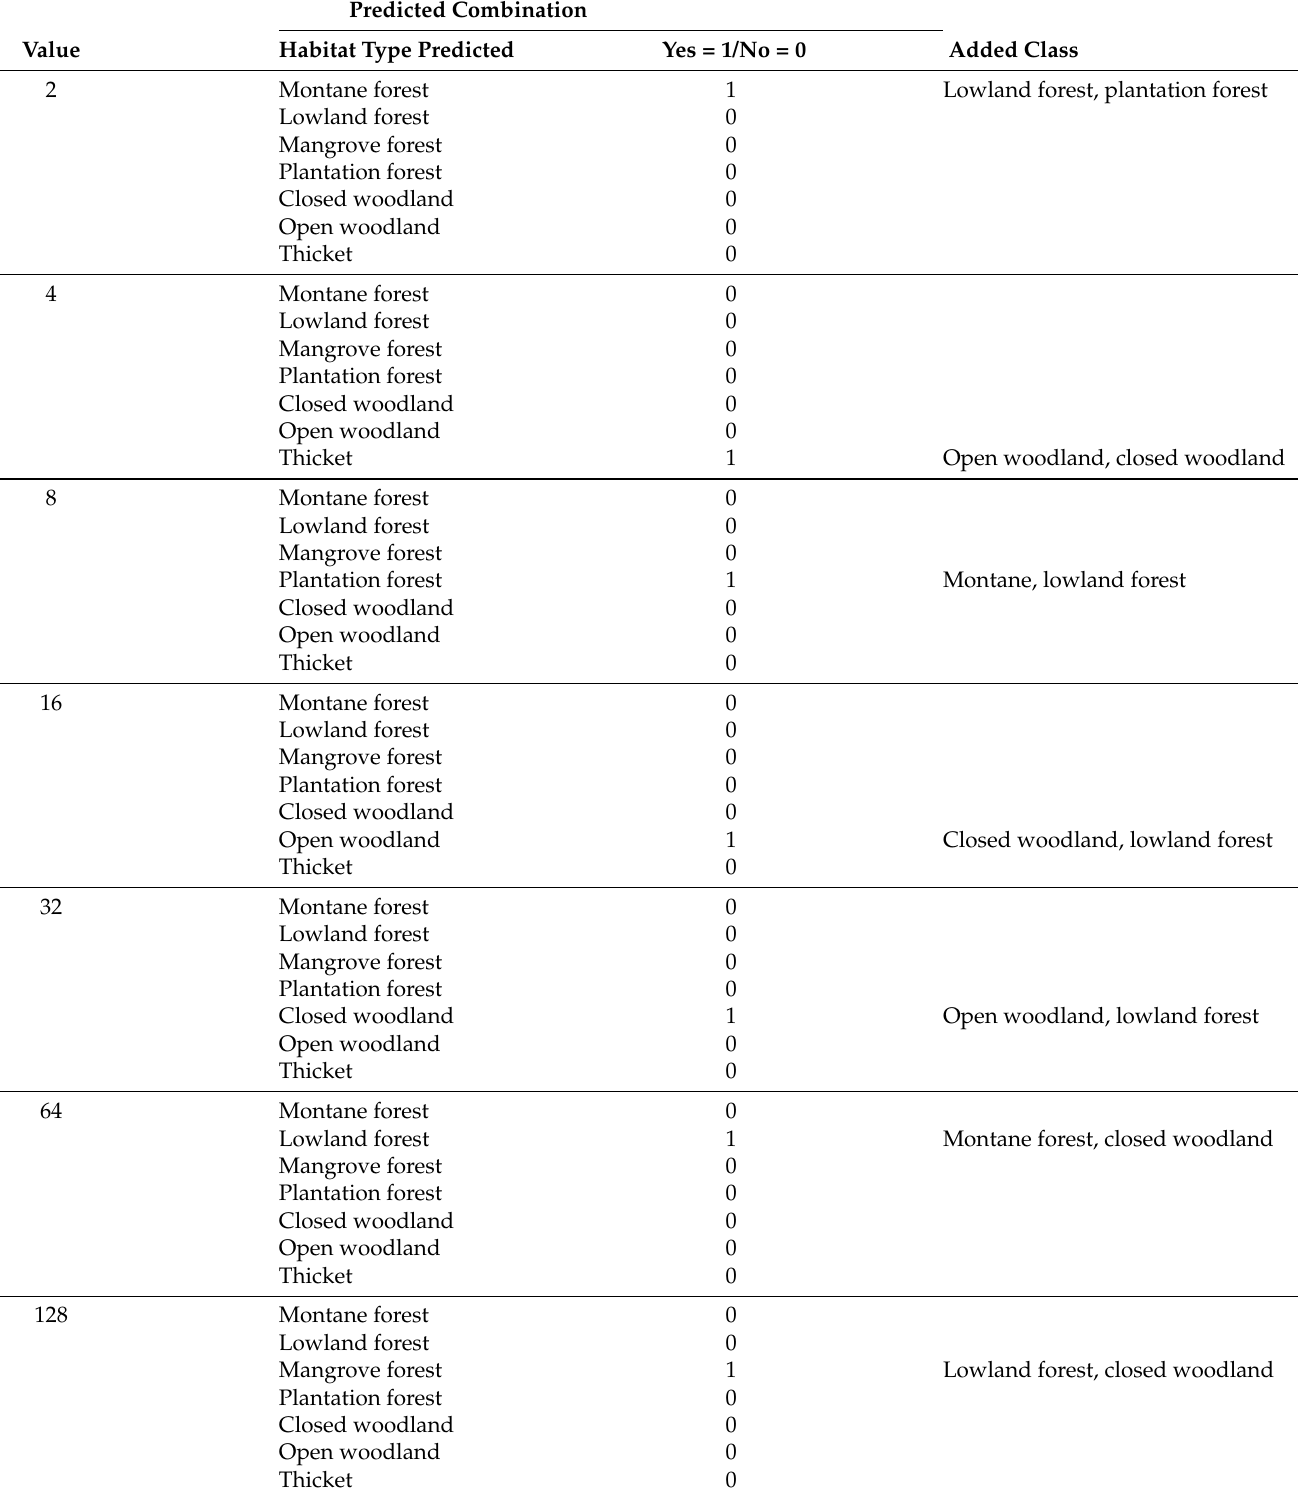
Table 1. A sample of predicted combined forest types suitability depicting single classes occurrences. Therefore, a second class was added in these situations to enable the classifier to perform